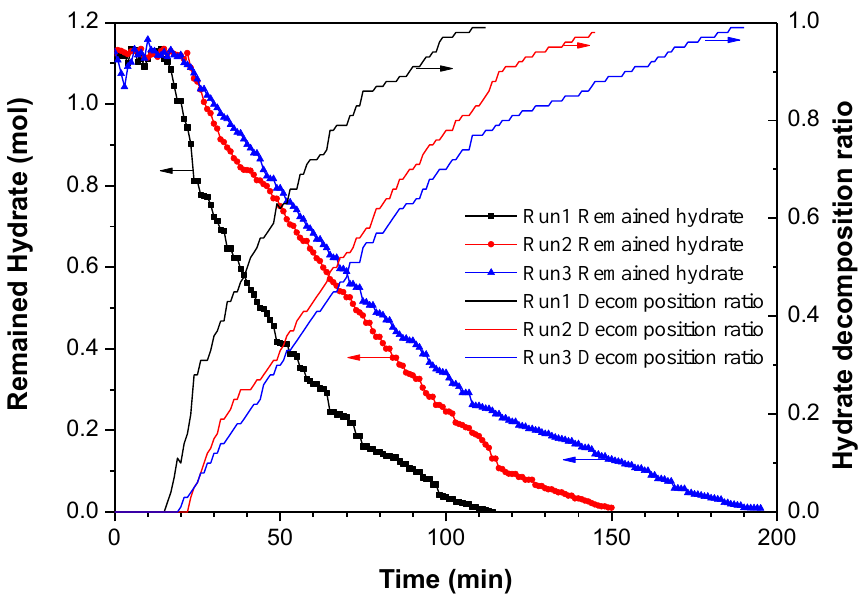
Figure 7. Changes of the remaining hydrate in the sediment and the hydrate decomposition ratio for runs 1 3.